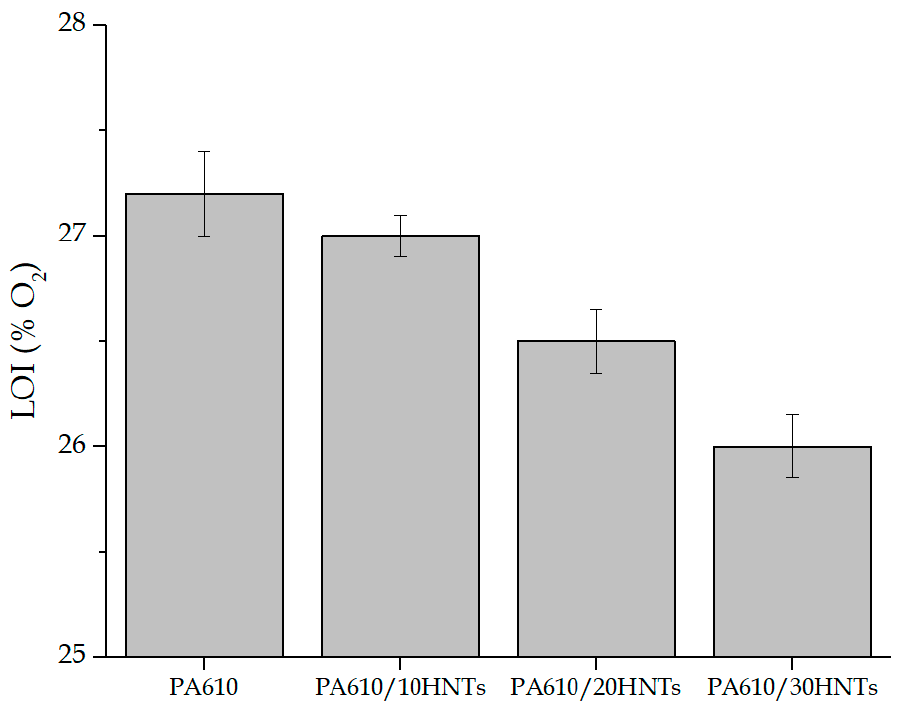
Figure 9. Graphic representation of the limiting oxygen index (LOI) values of each sample.